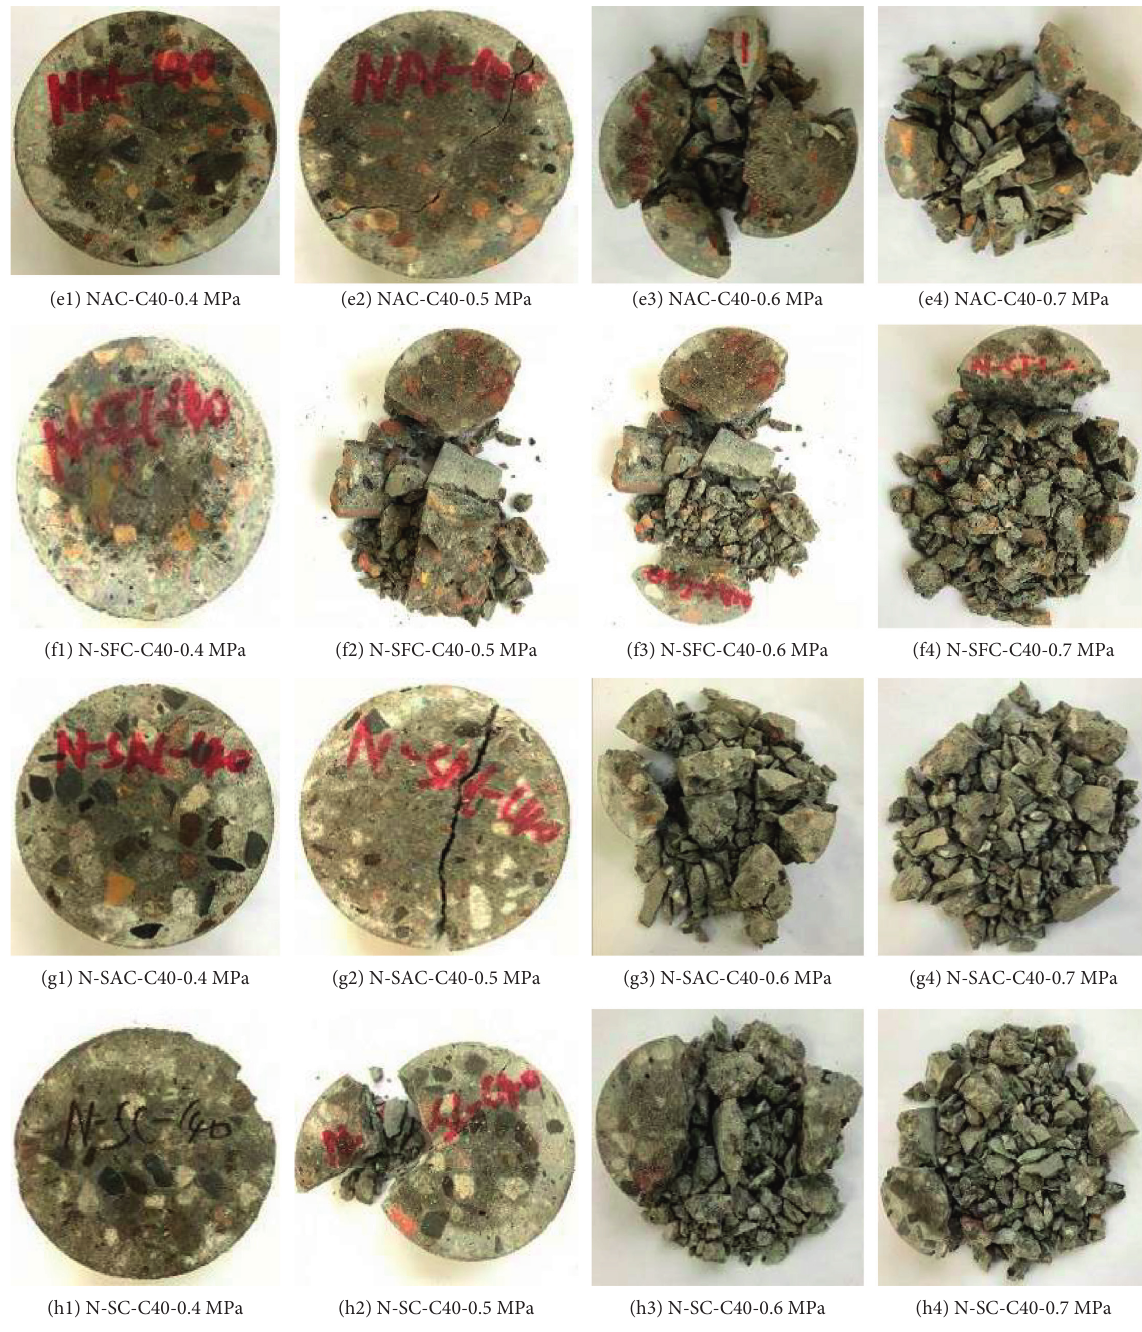
Figure 14: Impact specimen after